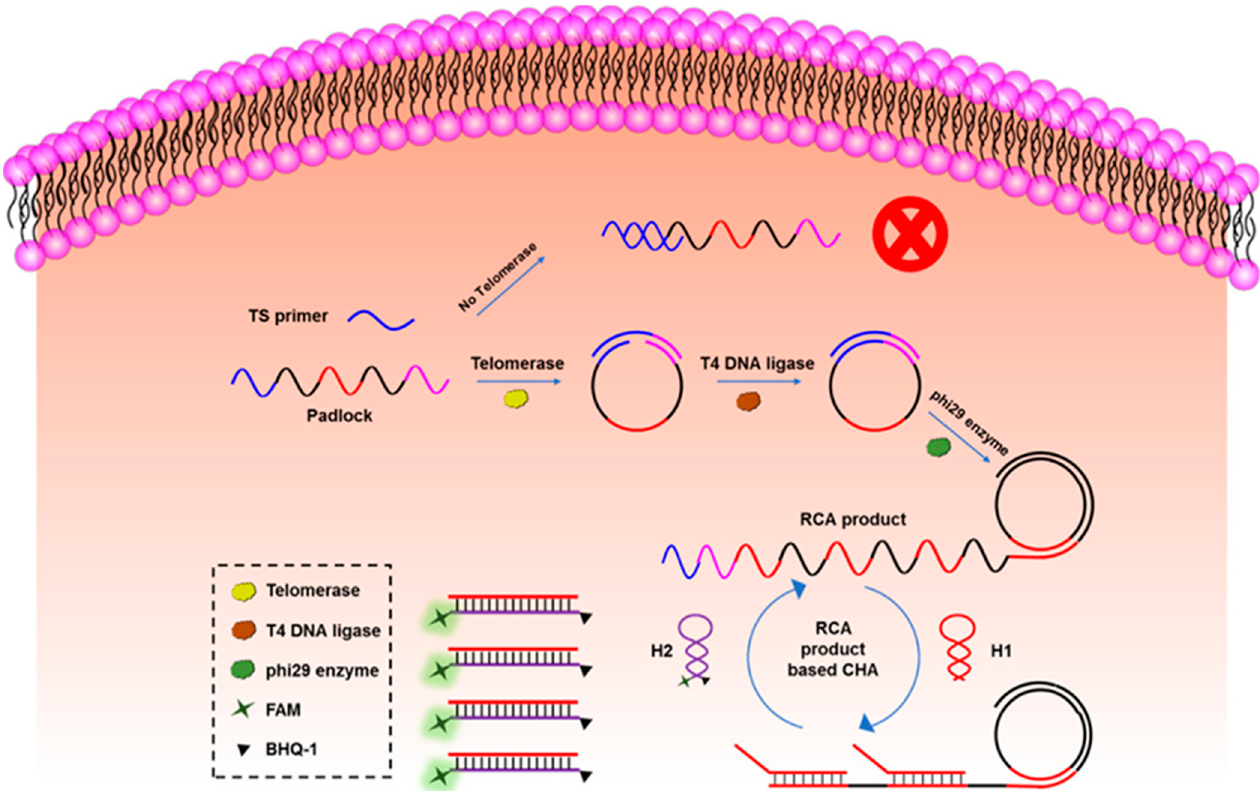
Figure 6. The principle of CHA-assisted RCA for telomerase activity detection. Reprinted (adapted) with permission from [123]. Copyright (2020) American Chemical Society.